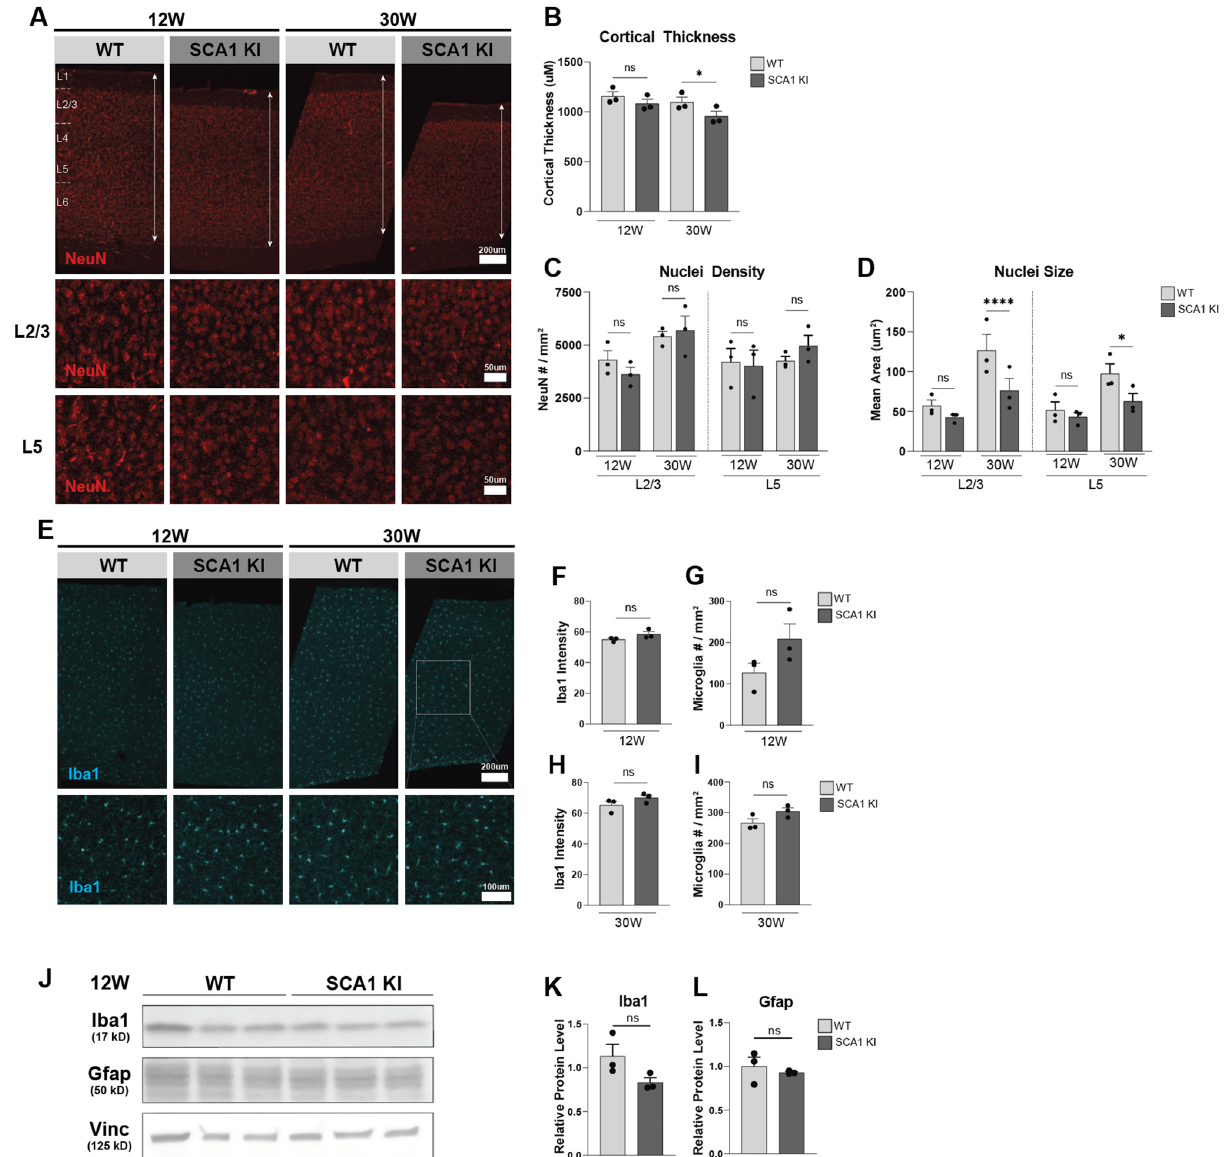
Figure 1. Progressive cortical thinning in the SCA1 KI mice. ( A ) Representative images of NeuN- positive neurons in 12-week and 30-week WT and SCA1 KI motor cortex, with insets of layers 2/3 and 5 (Scale bar top panel 200 μ m, middle and bottom panel insets 50 μ m), quantified in ( B – D ). ( B ), Quantification of cortical thickness in SCA1 KI and WT littermate controls at 12 and 30 weeks. ( C , D ), Quantification of NeuN-positive neuron number per mm 2 ( C ) and nuclei area ( D ) in SCA1 KI and WT littermate controls at 12 and 30 weeks in cortical layers 2/3 and 5 (n = 3 animal per genotype, with 3 images per animal). ( E ), Representative images of Iba1-positive microglia in 12-week and 30- week WT and SCA1 KI motor cortex (scale bar top panel 200 μ m, bottom panel inset 100 μ m), quan- tified in ( F – I ). ( F , G ), Quantification of Iba1-positive microglia intensity ( F ) and number per mm 2 ( G ) ( p -value = 0.1339) in 12-week SCA1 KI cortex, compared to WT controls. ( H , I ), Quantification of Iba1-positive microglia intensity ( H ) and number per mm 2 ( I ) in 30-week SCA1 KI cortex, compared to WT controls (n = 3 animal per genotype, with 3 images per animal). ( J ), Western blot images of Iba1 and Gfap protein expression in SCA1 KI and WT cortex at 12 weeks, with Vinculin (Vinc) as a loading control. ( K , L ), Quantification of Iba1 ( K ) and Gfap ( L ) protein expression levels from ( J ), normalized to Vinculin and WT expression levels, (n = 3 animal per genotype). (* p < 0.05, **** p < 0.0001, ns = not significant).